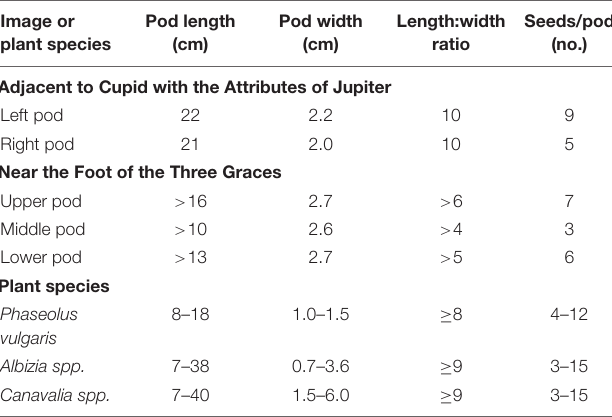
TABLE 3 | Legume pods in the festoons of the Loggia di Amore e Psiche in the Villa Farnesina compared to large-seeded legume genera. Image or plant species